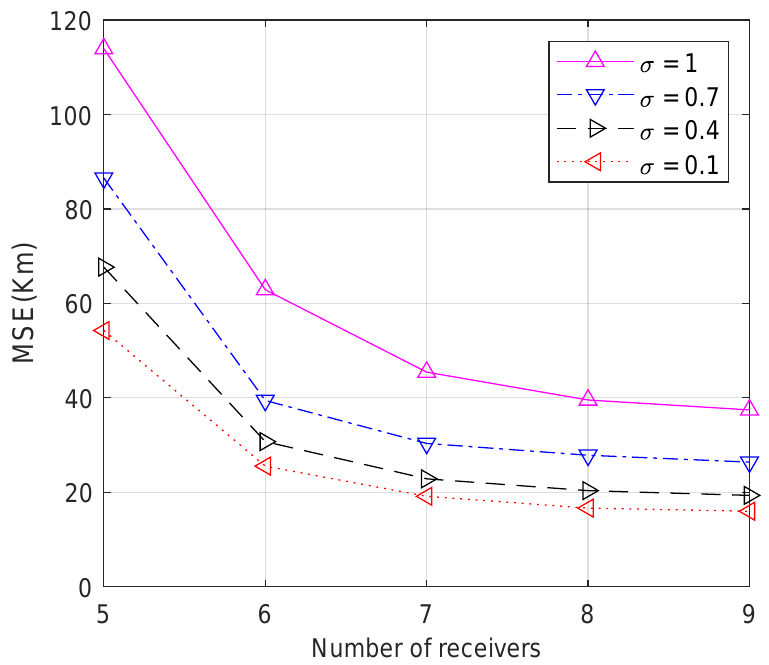
Figure 4. MSE of HF source position estimation with different numbers of receivers and different values of σ .